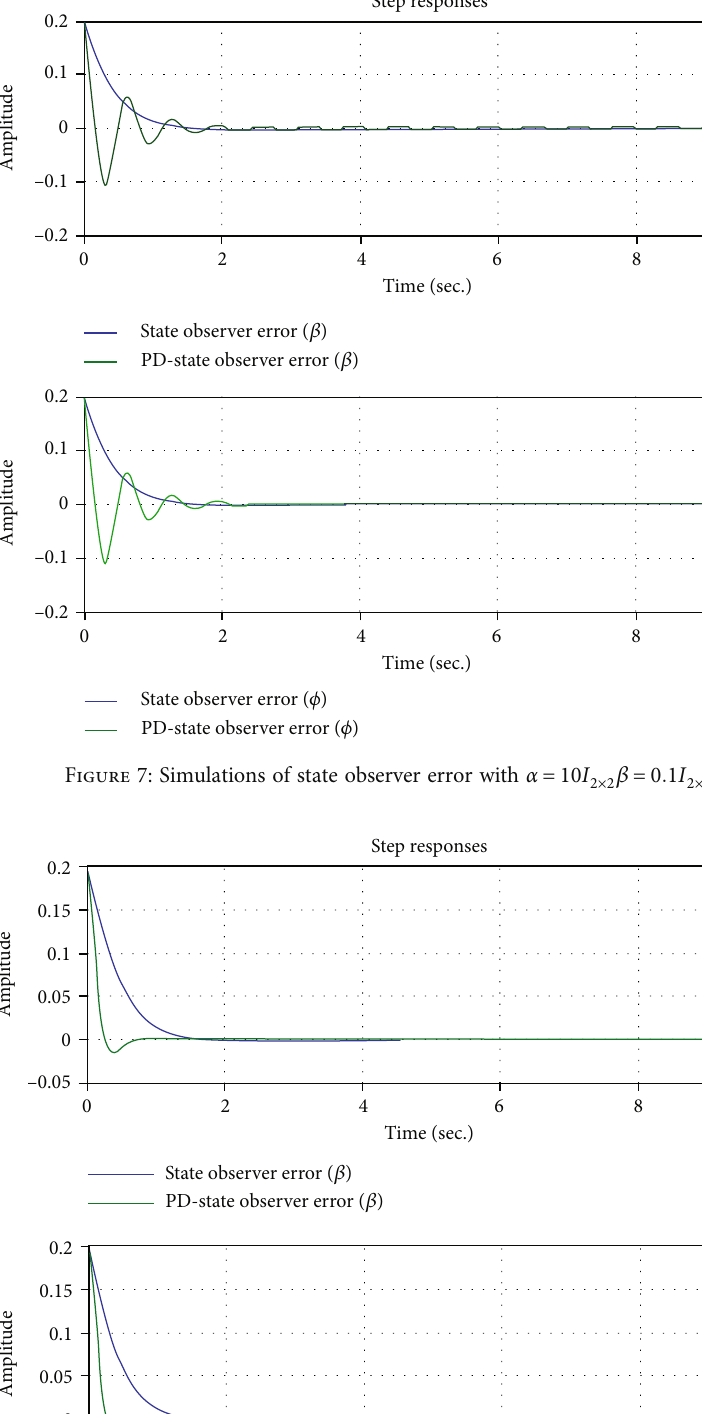
Figure 8: Simulations of state observer error with α = 10 I